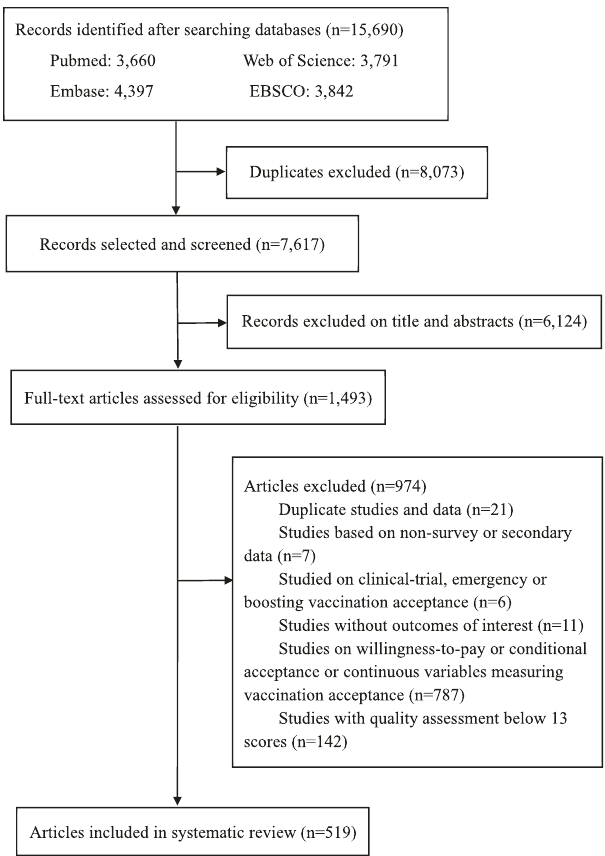
Fig. 1 Flowchart of study selection. Selection of original survey studies on acceptance, willingness, intention, or uptake of COVID-19 vaccination is shown via fl